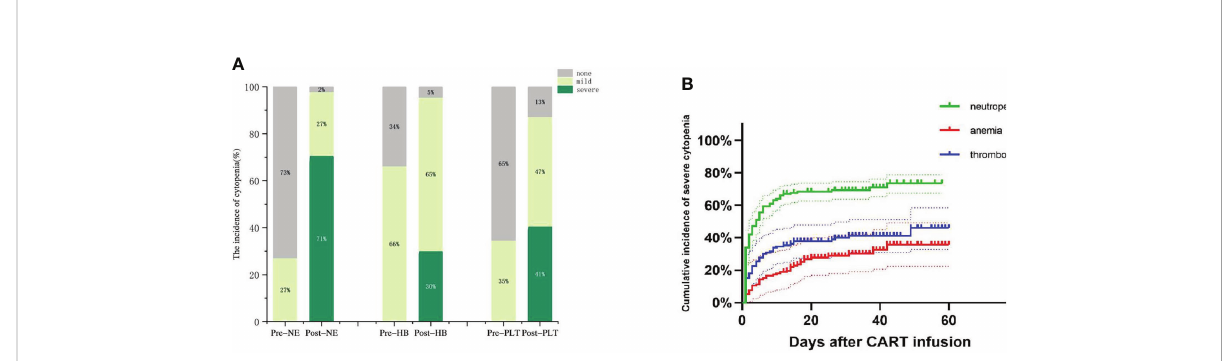
FIGURE 2 Hematologic toxicity after CAR-T cells. (A) The incidence of cytopenia before and after CAR-T cell infusion. (B) Cumulative incidence of severe